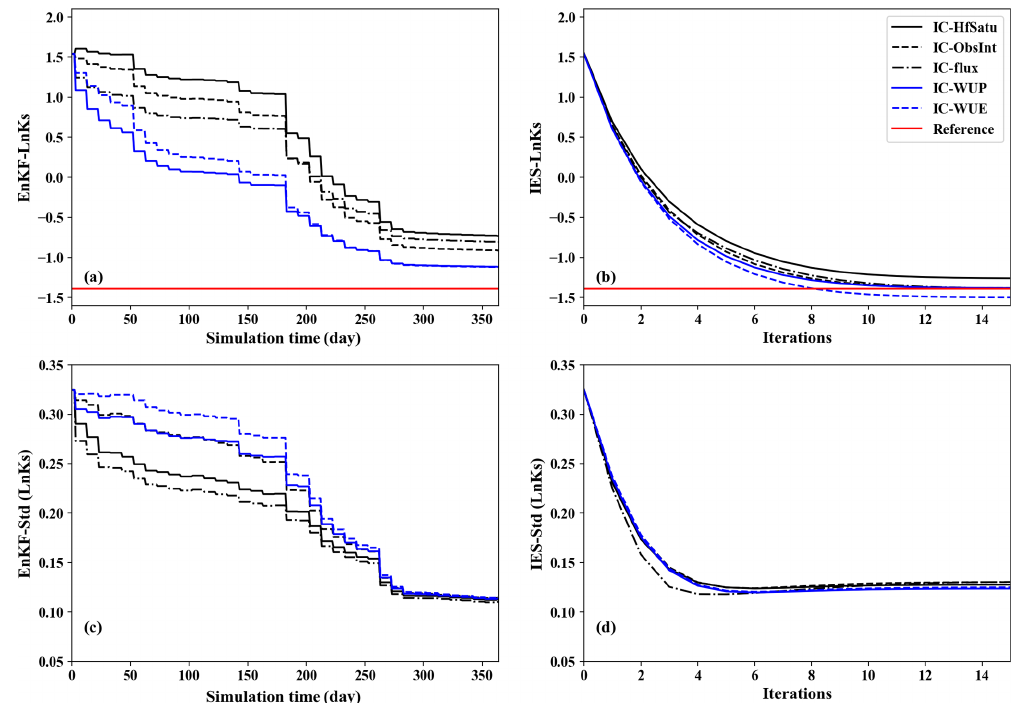
Figure 6. The results of ln K s estimations (a, b) and their associated standard deviations (c, d) within two data assimilation frameworks ( a, c : EnKF; b, d : IES) under five initialization methods (Case